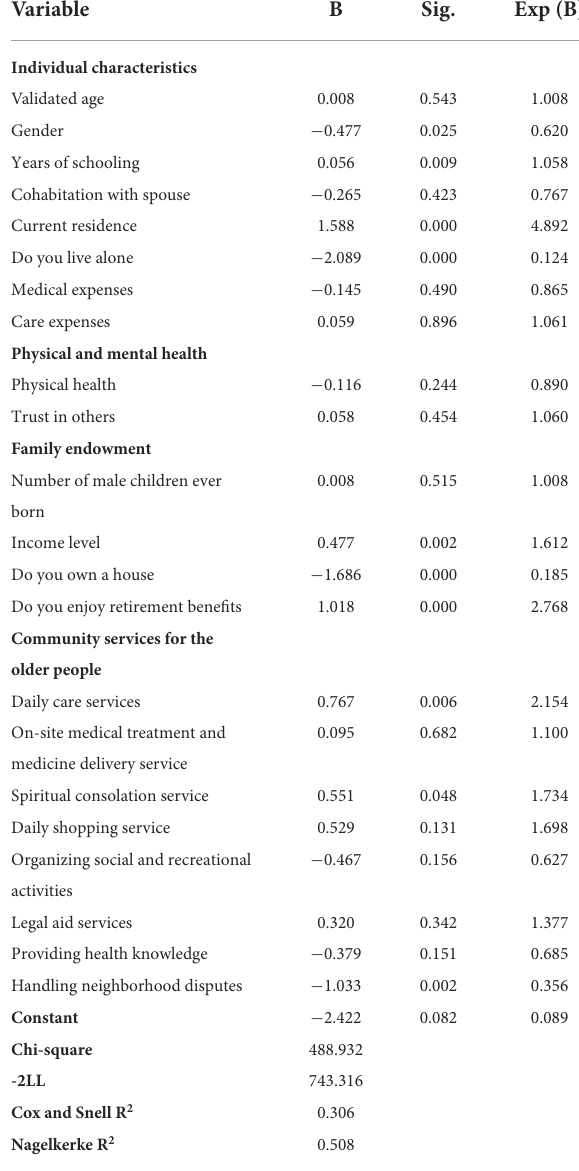
TABLE 3 Logistic regression analysis of factors influencing the choice of care types for older people with disability.